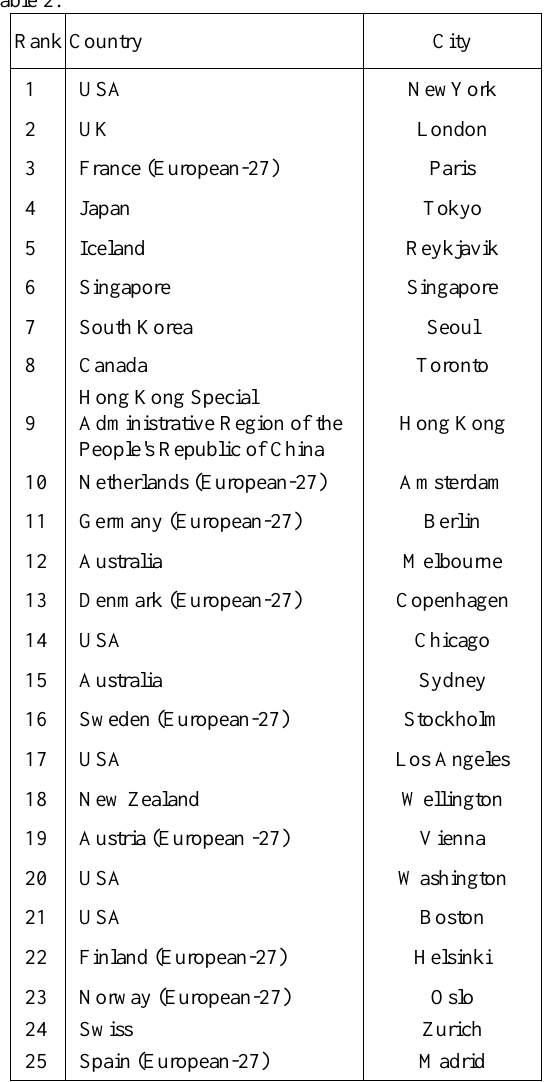
Table. 2 The smartest 25 city of the world (Berrone et al. 2019) According to this ranking, New York has become the smartest city in the world. 9 dimensions addressed when ranking